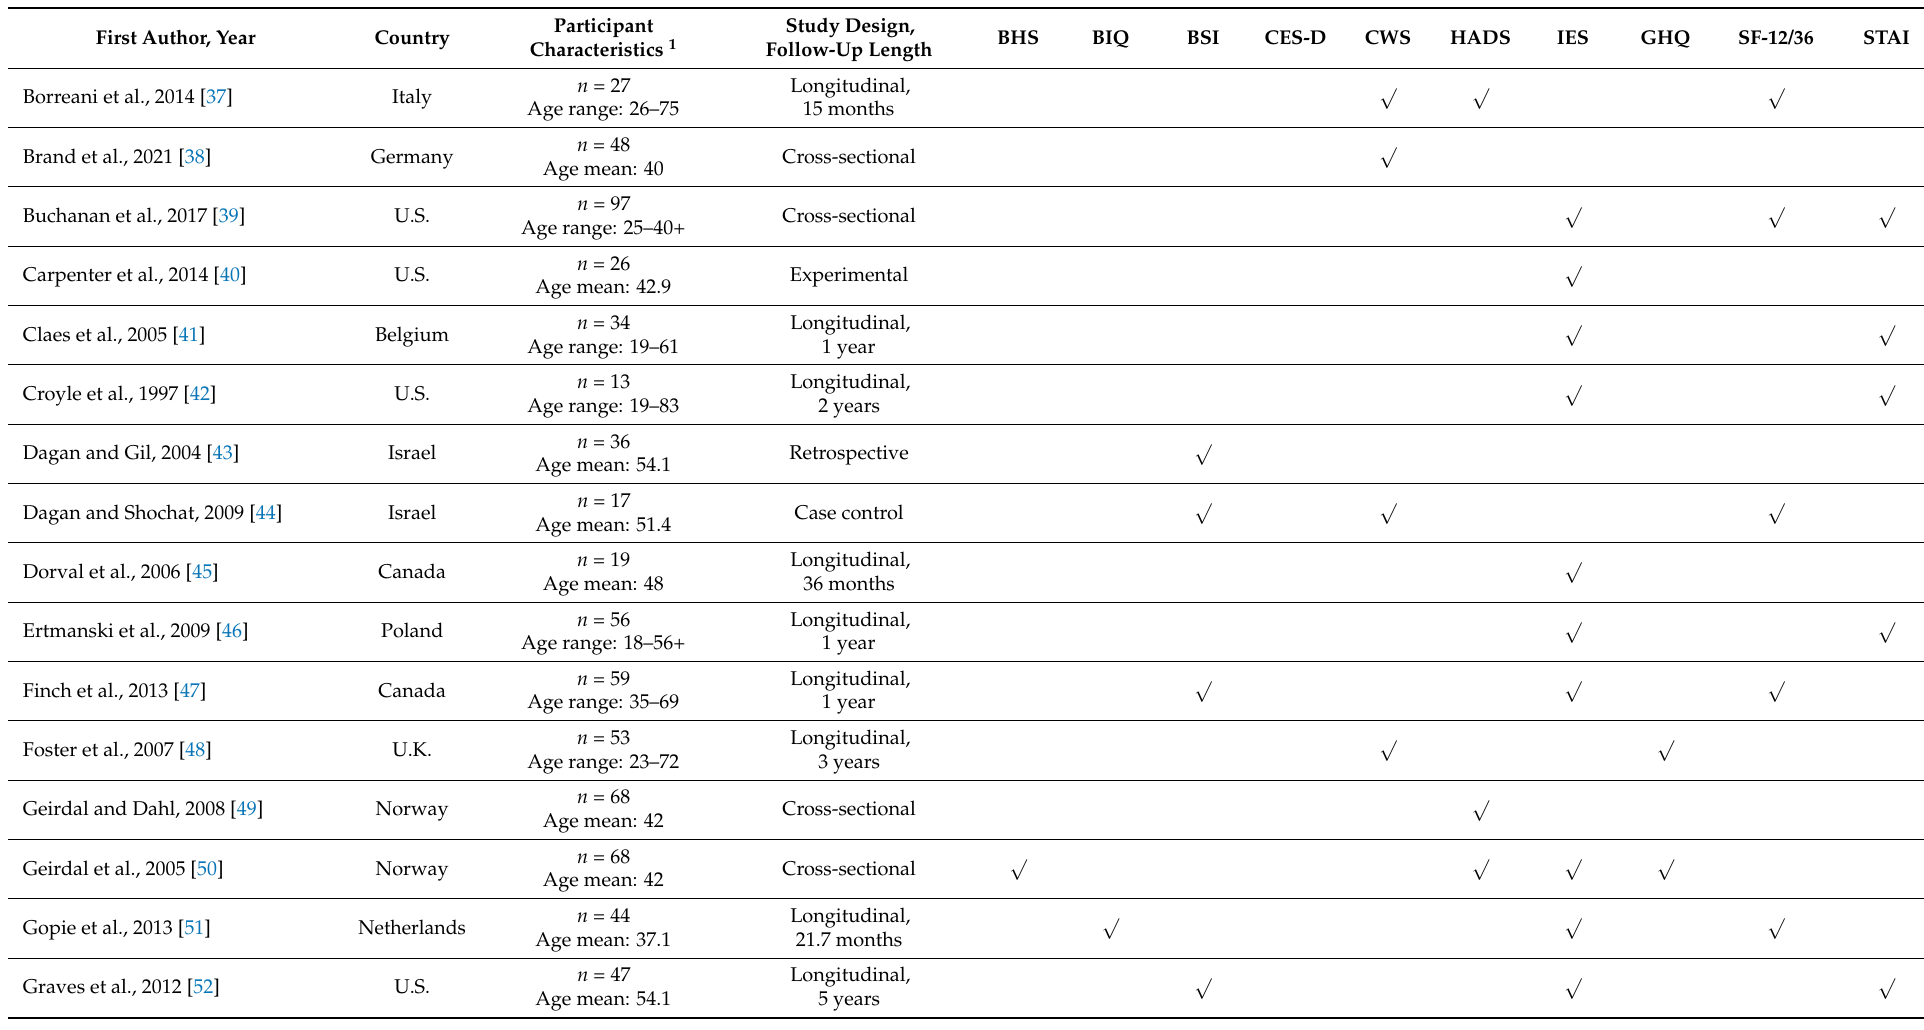
Table 1. Descriptive data of the studies ( n = 45) and measures